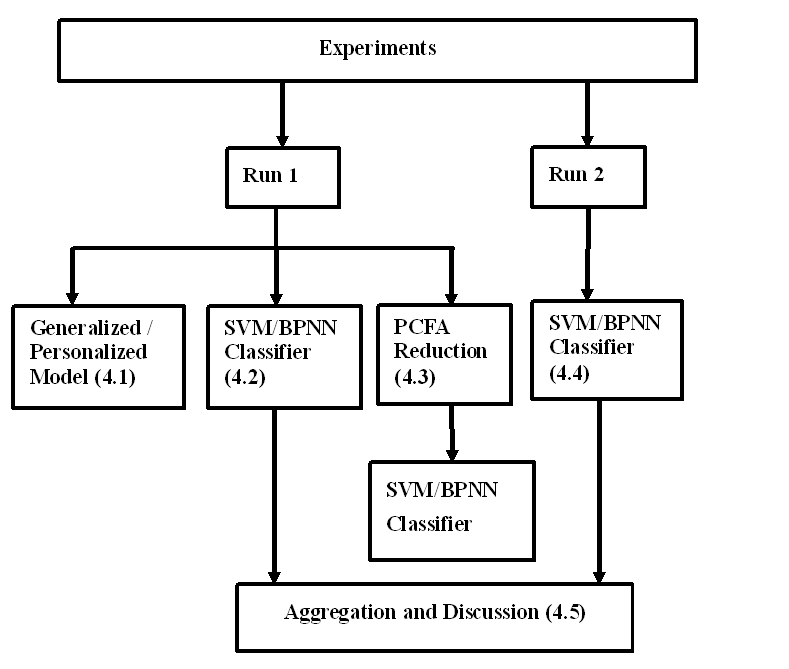
Figure 3. Framework of the experiments.